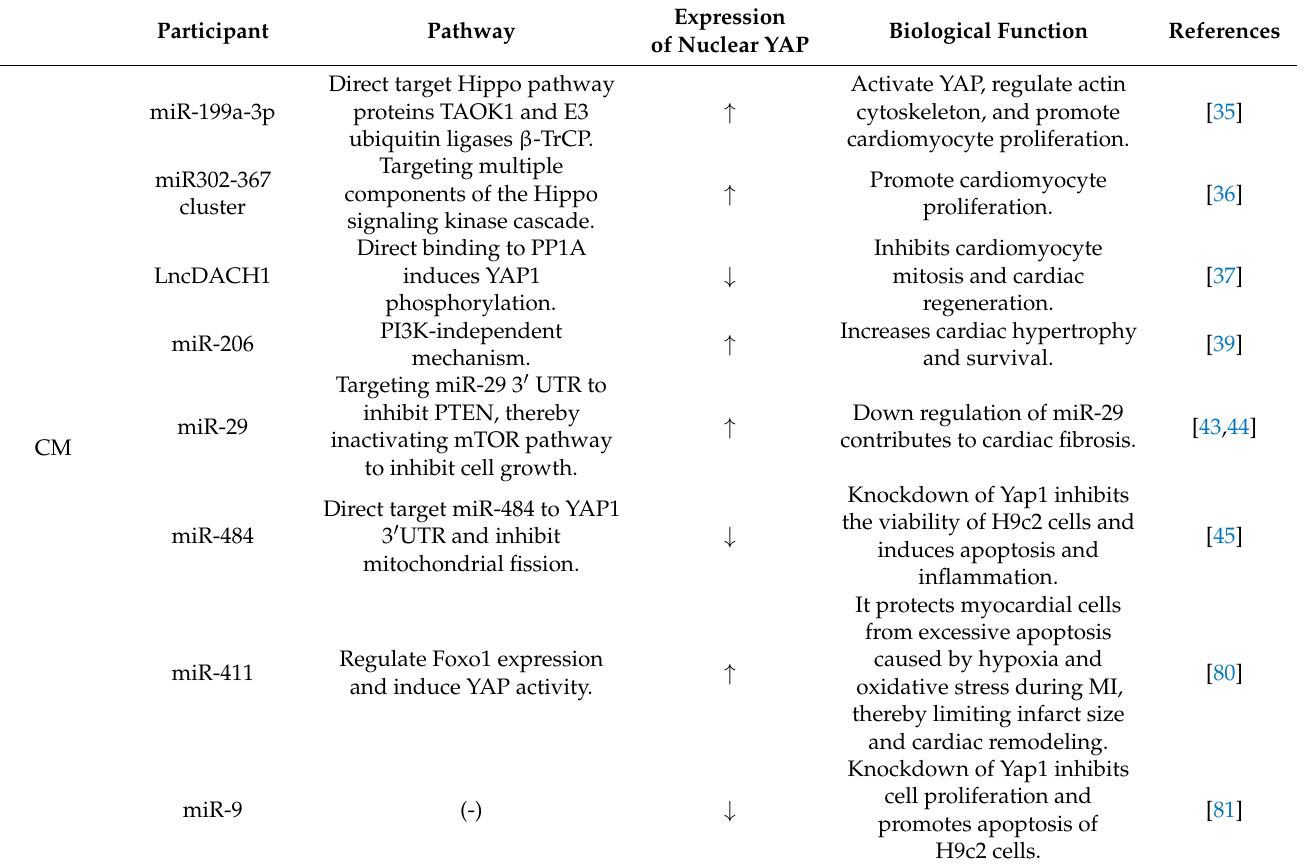
Table 1. Targeting different cells or cellular constituents of YAP/TAZ signaling proteins in myocardial infarction. ↑ , Increased; ↓ ,